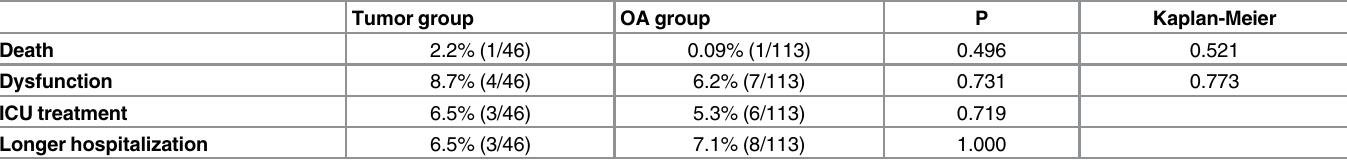
treatment or longer hospitalization (more than 1 month) between two groups (Table 3). With the data available, none of the following indexes like gender, age (cid:1) 60 years, BMI > 25kg/m 2 , malignant tumor, previous pathological fracture, histological type of tumor, tumor location chemotherapy or radiotherapy was found to be significantly associated with the occurrence of VTE or DVT (Table 2). For OA patients, gender, age (cid:1) 60 years, BMI > 25kg/m 2 failed to make a significant relation with the occurrence of VTE (Table 4). Analysis of group as a potential risk factor of VTE with multivariate cox regression showed no significant difference between two groups for symptomatic DVT and PE (Table 5). Additionally, we also made a subgroup Table 3. Comparison of major complications between two